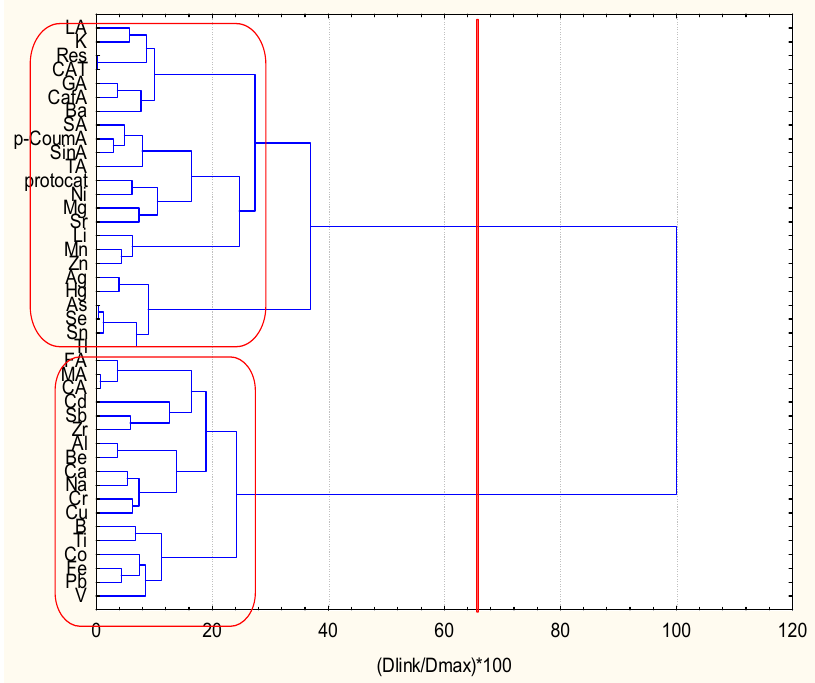
Figure 1. Hierarchical dendrogram for clustering of 42 variables.